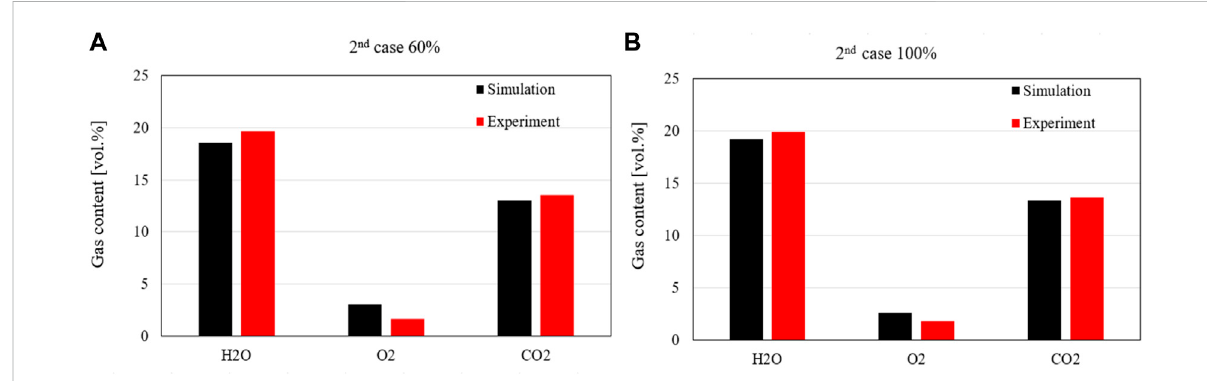
FIGURE 7 Gas composition of the second 60% (A) and 100% (B) load cases.